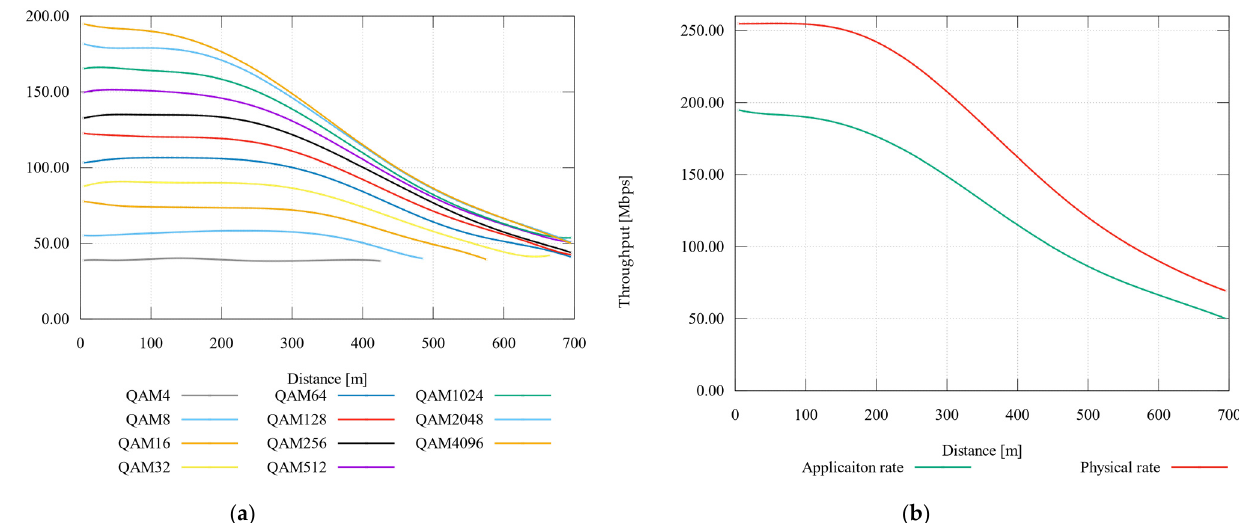
Figure 7. ( a ) Comparison of throughput with modulation sweep; ( b ) Comparison of application and physical rate—QAM4096.